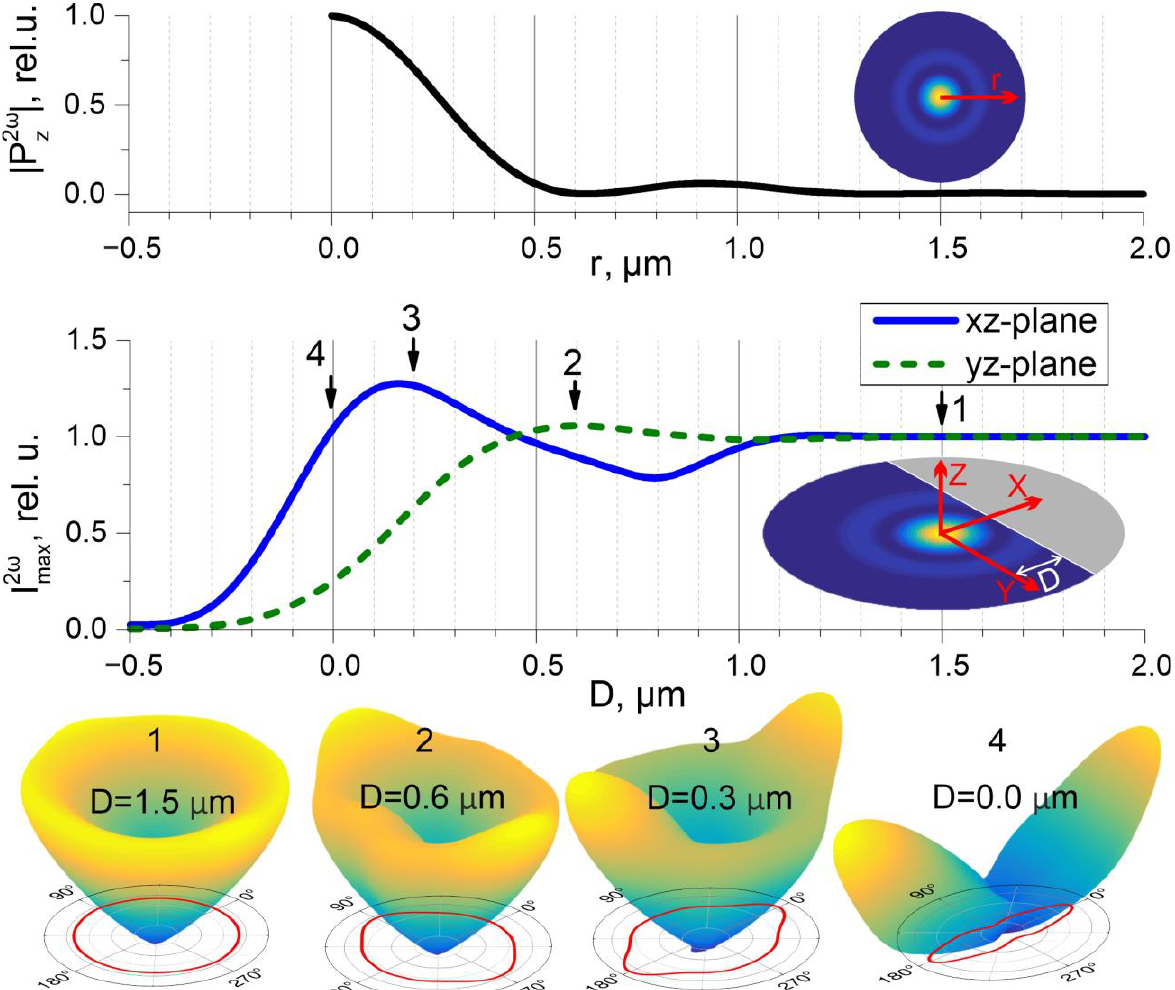
Figure 2. ( Upper row ): radial distribution of the nonlinear polarization (| P z 2 ω |) at the surface possessing χ (2) zzz -component of second-order susceptibility and excited by a radially polarized beam; inset: 2D-map of the polarization. ( Middle row ): maxima of the intensity of the SH radiation in xz - (solid curve) and yz -planes (dashed curve) vs. distance between the beam center and the edge of the nonlinear region ( D ); the axis and D are designated in the inset; negative D corresponds to the beam center falling over the edge. ( Lower row ): second harmonic radiation patterns for D = 1 .5 μm (1), D = 0 .6 μm (2), D = 0 .3 μm (3), D = 0 .0 μm (4); contours: maximal SH intensity vs. azimuthal direction.